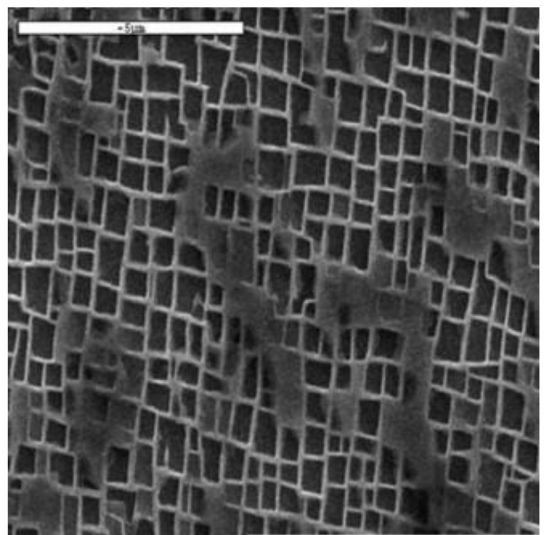
Figure 1. Scanning electron microscopy (SEM) micrograph of the CMSX-4 ® microstructure, showing cuboidal γ ’ precipitates surrounded by the primary γ matrix. Reproduced from